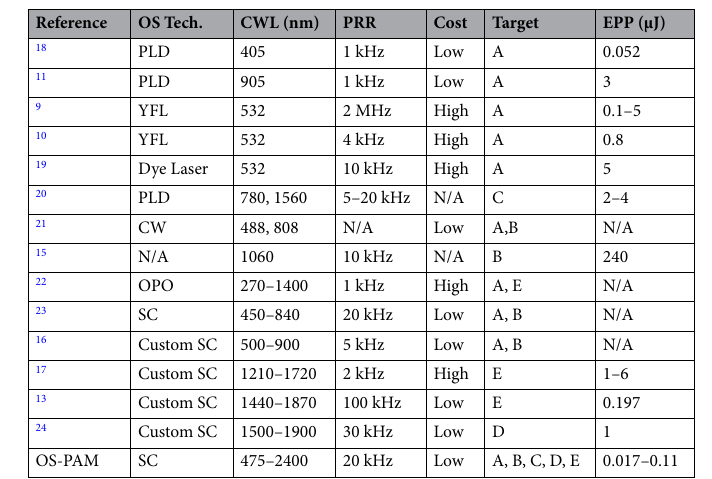
Table 1. Review of the instrumentation used for PAM imaging of hemoglobin (A), melanin (B), collagen (C), glucose (D) and lipids (E). OS optical source employed, CWL central wavelength of OS, PRR pulse repetition